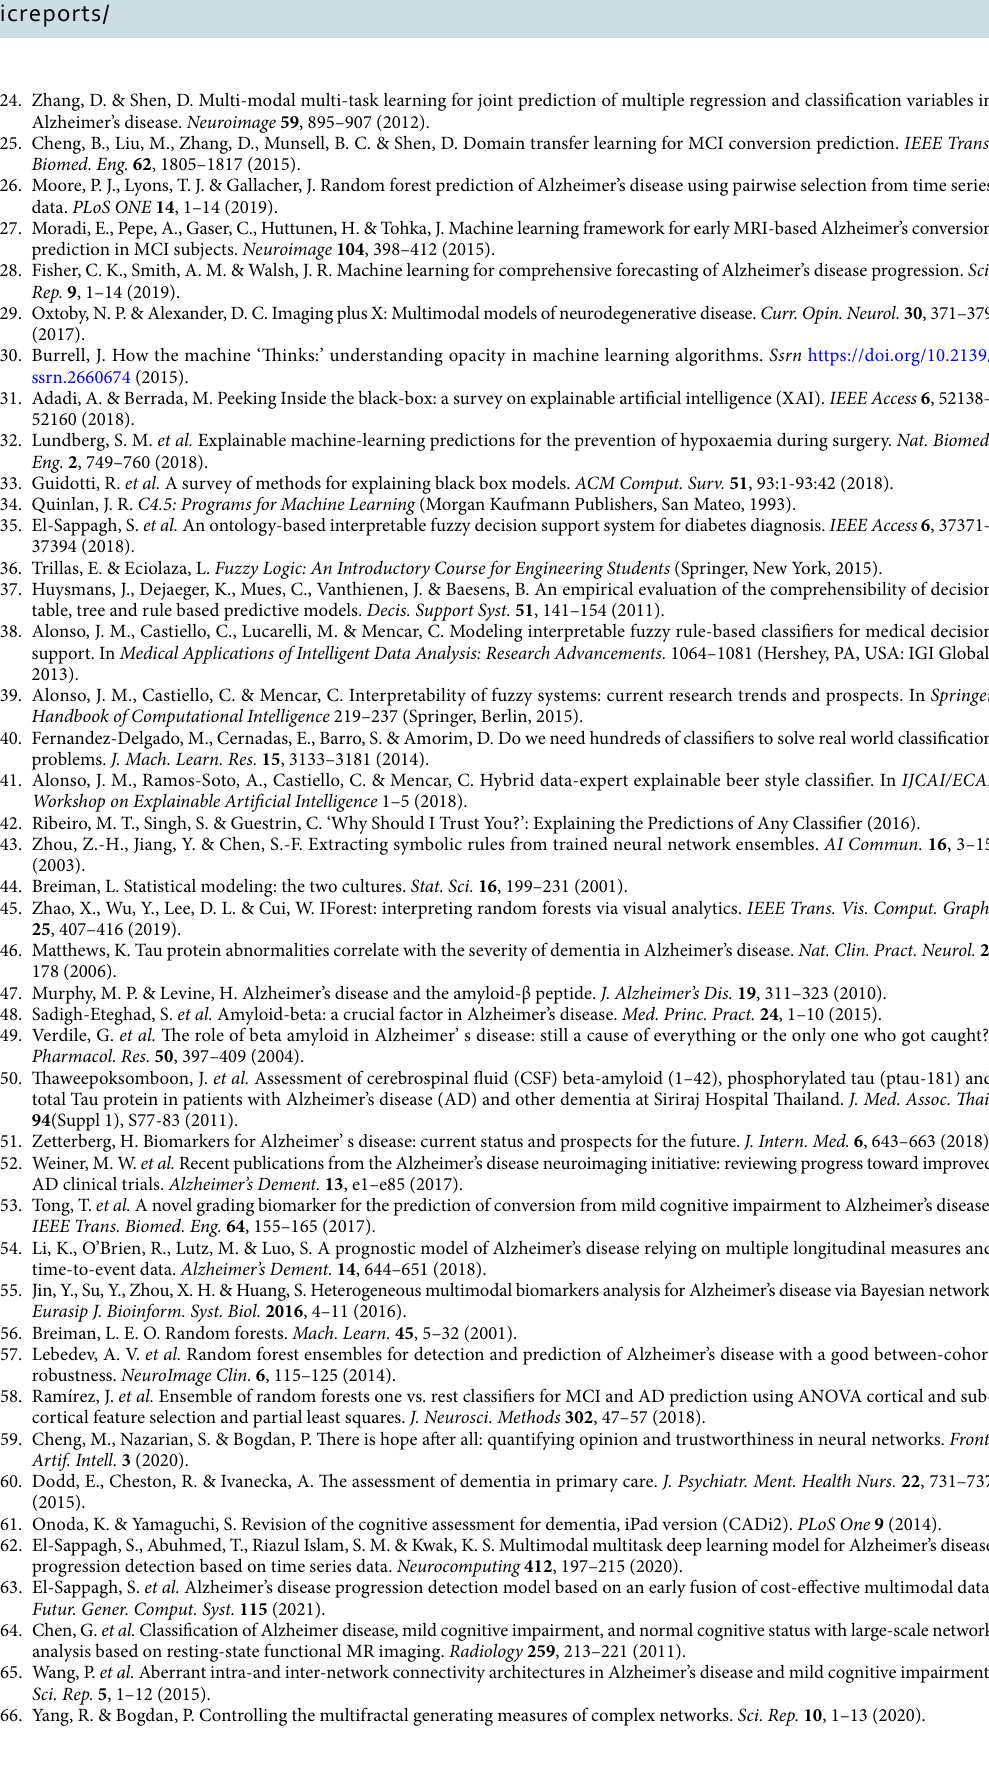
table, tree and rule based predictive models. Decis. Support Syst. 51 , 141–154 (2011). 38. Alonso, J. M., Castiello, C., Lucarelli, M. & Mencar, C. Modeling interpretable fuzzy rule-based classifiers for medical